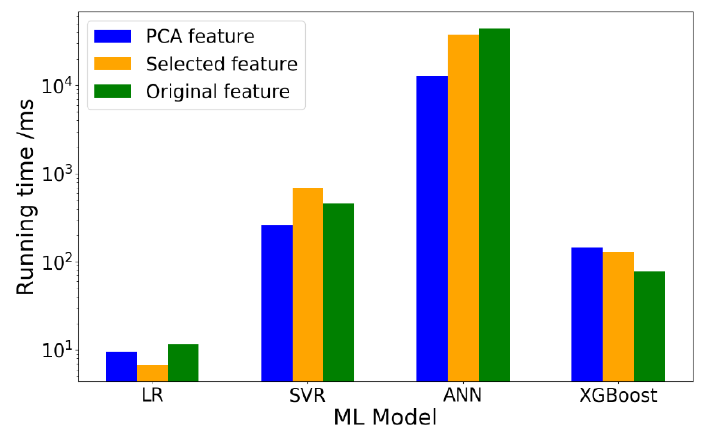
Figure 18. Running time of trainset under different ML model.